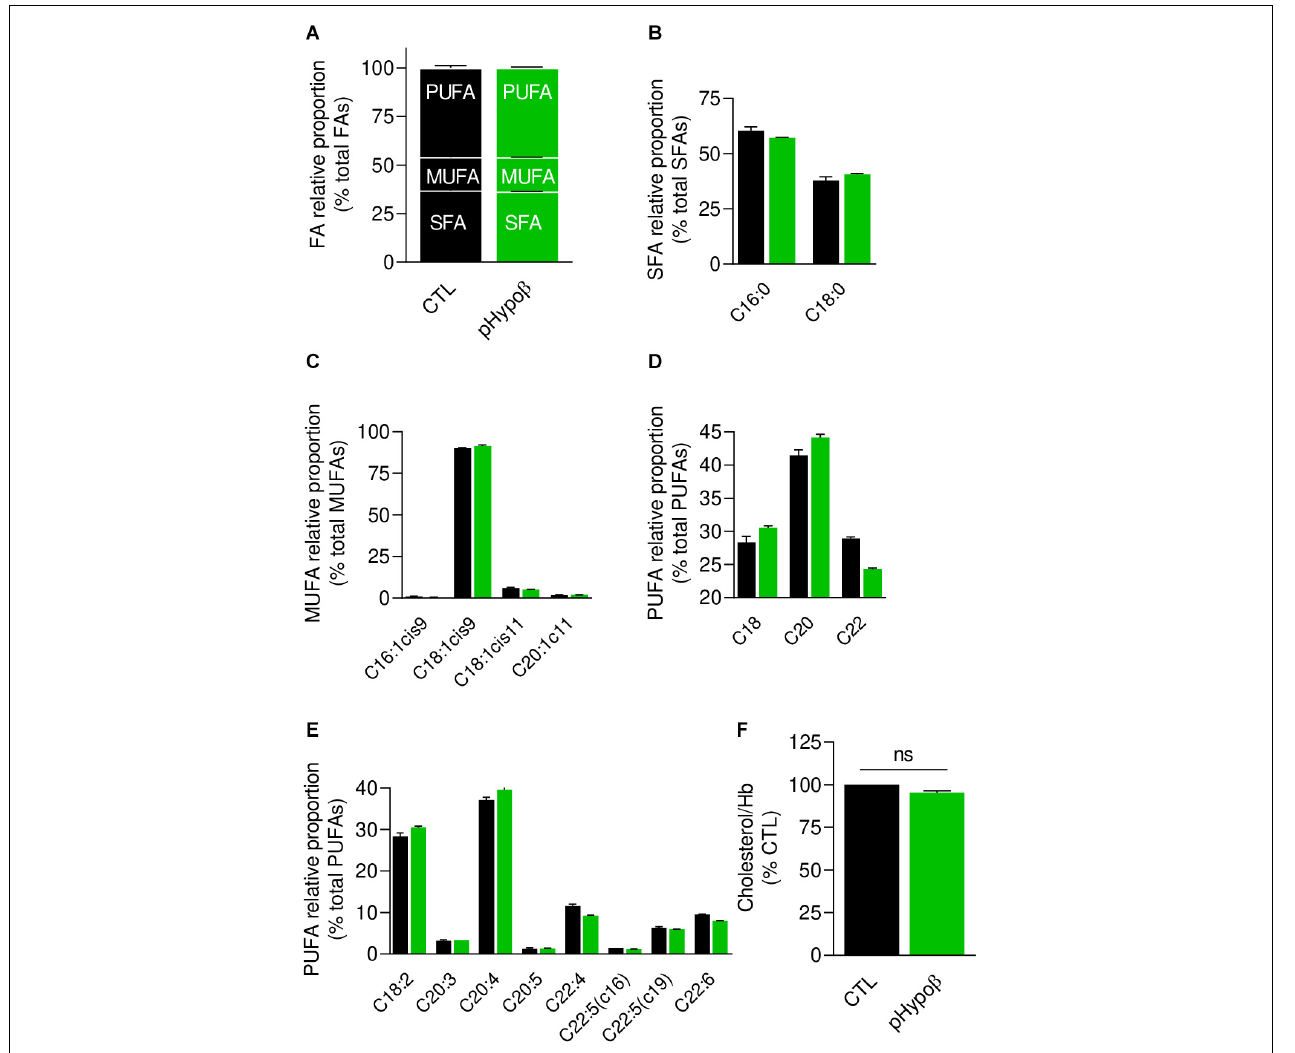
FIGURE 3 | Membrane fatty acid and cholesterol contents are largely preserved in pHypo β RBCs. RBCs from healthy donors (black columns) or pHypo β (green columns) were evaluated for membrane fatty acid (FA) content (A–E) and cholesterol level (F) . (A–E) RBC FA composition. Lipids were extracted from isolated RBCs and prepared for gas chromatography to analyze FA content. (A) Relative proportion of saturated (SFA), monounsaturated (MUFA) and polyunsaturated (PUFA) FAs expressed as percentage of total FAs. (B) Relative proportion of the two major SFAs (C16:0 and C18:0). (C) Relative proportion of the four major MUFAs (C16 and C18 with one double bond on position 9 and C18 and C20 with one double bound on position 11). (D) Relative proportion of PUFA according to the carbon chain length (chains of 18, 20, or 22C). (E) Relative proportion of the major PUFAs (chains of 18–22C and 2–6 double bonds). All data are means ± SD of triplicates from